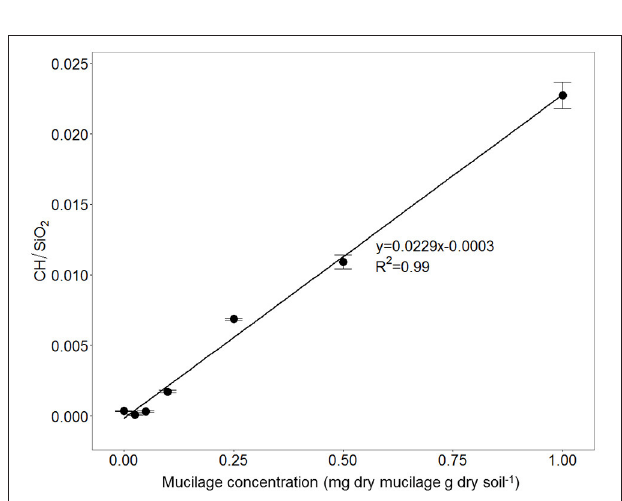
FIGURE 6 | Ratio between CH and SiO2 signal for soil mixed with different maize-mucilage concentrations collected from maize seedlings ranging from 0 to 1mg dry mucilage per g dry soil.